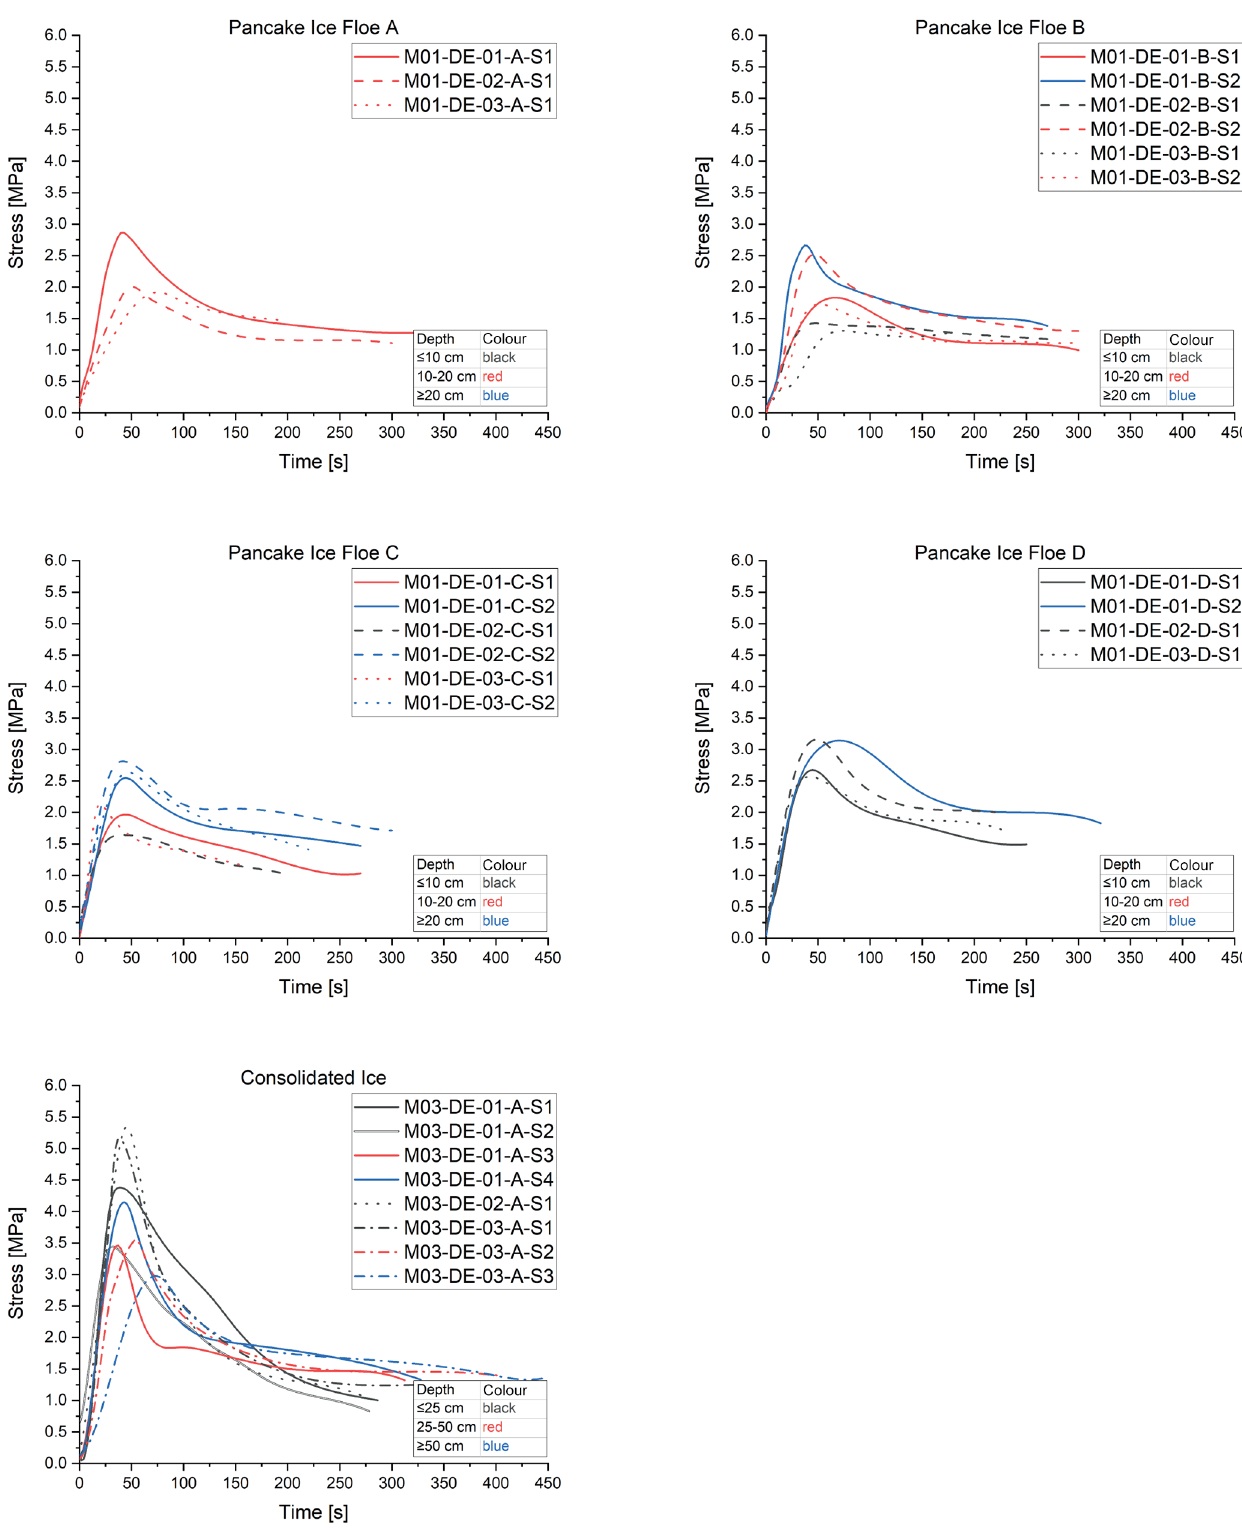
Figure 15. Stress–time plots of uniaxial compression test results for all specimens, the respective pancake ice floes and consolidated pack ice. The colour coding refers to the sample depth in centimetres along the core length measured at the sample centre and the line style to the specific